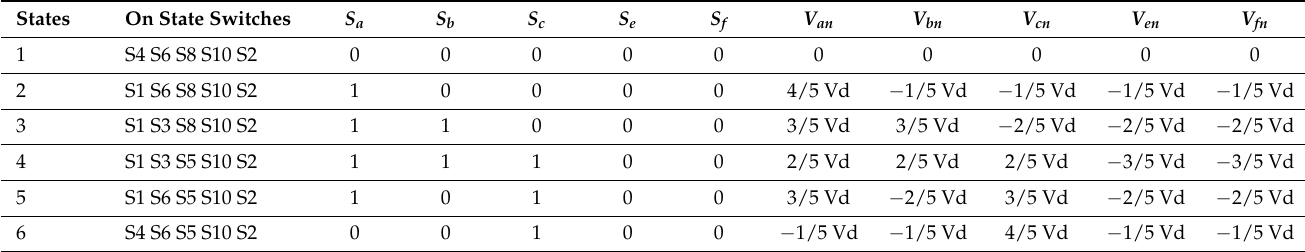
Figure 2. Five phase ‐ inverter—line voltage.